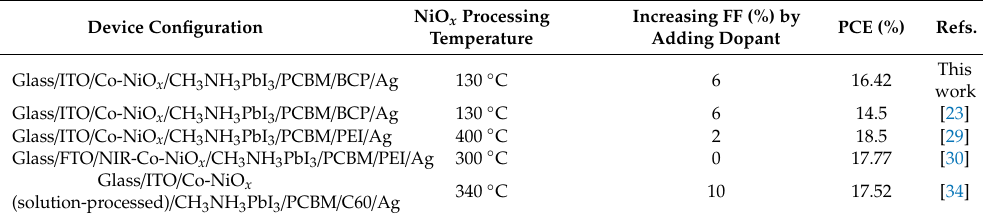
Table 1. NiO x processing temperature and the corresponding best e ffi ciency obtained for inverted perovskite solar cells; ITO: Indium tin oxide; PCBM: Phenyl-C61-butyric acid methyl ester; BCP: